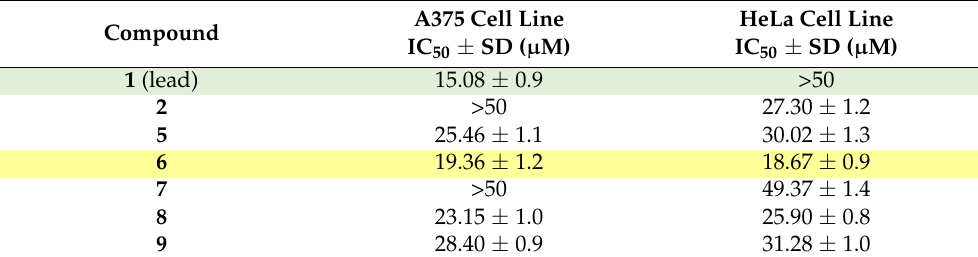
Table 2. Antiproliferative activity of 1 , 2 and 5 – 9 : IC 50 ( µ M) ± SD, 48 h; human melanoma cell line (A375) and human cervical adenocarcinoma cell line (HeLa).